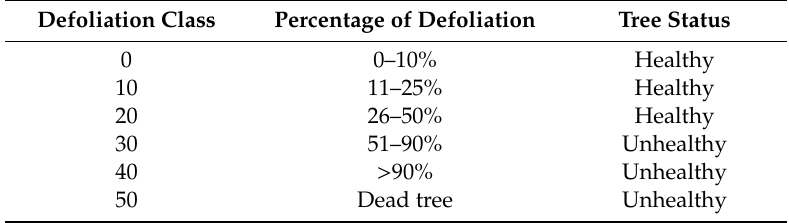
Figure 2. Location of the cork oak trees (green circles) considered for in situ measurements in Herdade da Machoqueira do Grou (HMG). Table 2. The degree of defoliation by cork oak class considered in this study.